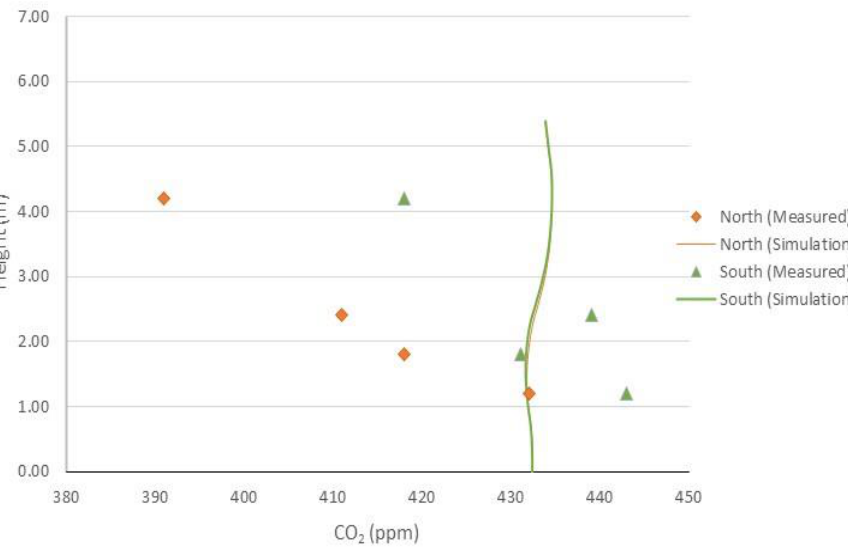
Figure 10. CO 2 concentration of measurement (north ♦ and south ▲ ) and simulation (north and south –) data according to the position from the ground. Table 4. Comparison of CO 2 concentration between measured and simulated data for model vali- dation in greenhouse.